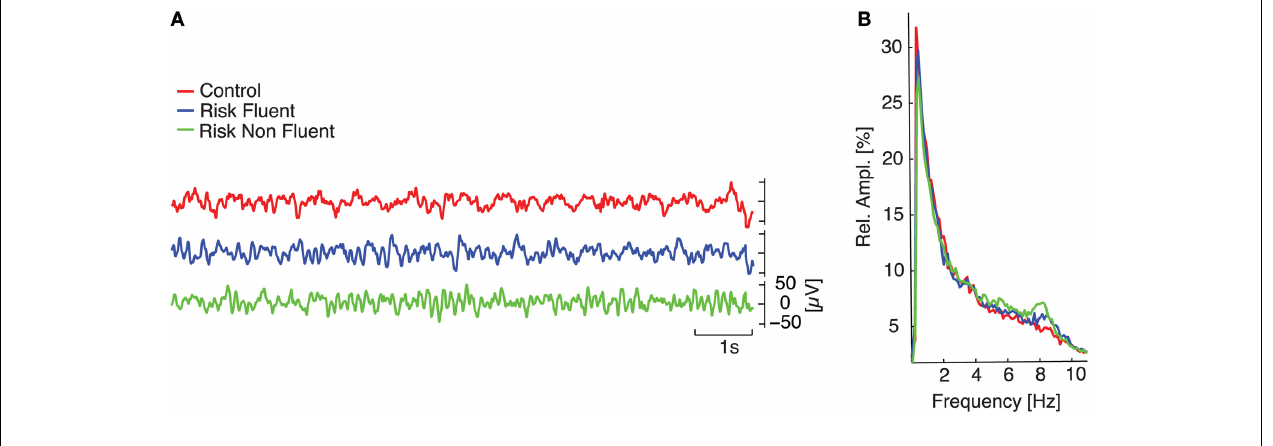
FIGURE 1 | EEG spectral analysis. (A) temporal evolution of 10s of filtered signals (0.4–30Hz) at the central electrode (Cz) for three children belonging to each of the different groups (red line refers to